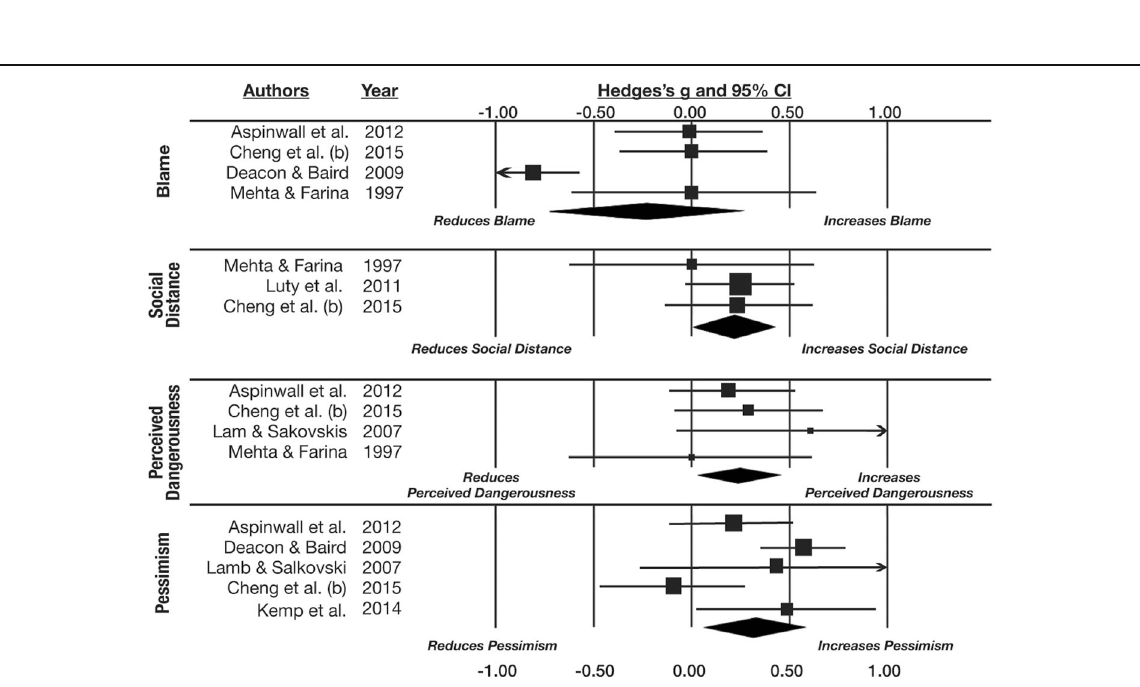
Fig. 2 Plots show meta-analyses of the experimental